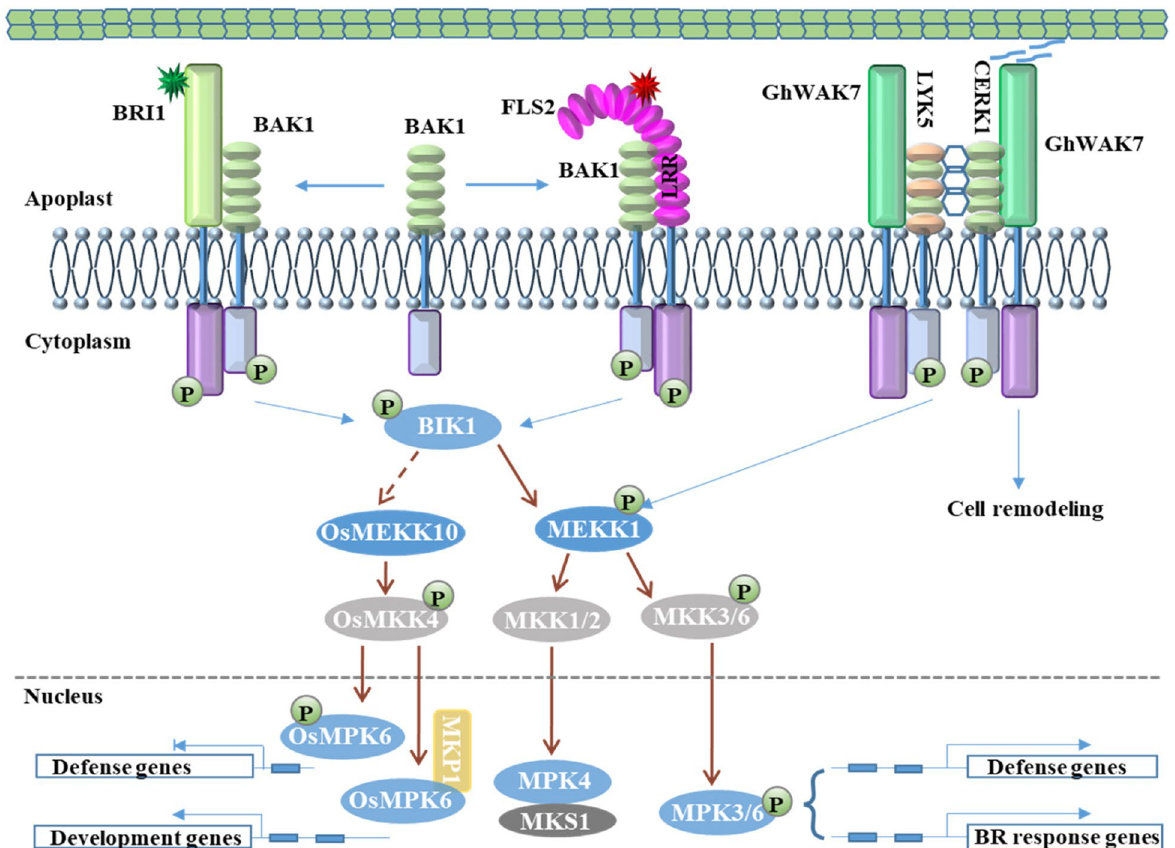
Fig. 1 Schematic illustrations SERKs, WAKs and MAPK cassette trade-off in regulating development and defense gene expression. The cell wall is indicated in a format with green brick bars. Note that plasma membrane components interact with each other in a competed manner to display with left and right arrows. The outline and shapes of RLK structures tethering PM are purely schematic; their size and number are only simulating protein domains. The signal P represents phosphorylation in different components and the phosphorylated order is schematic with arrows